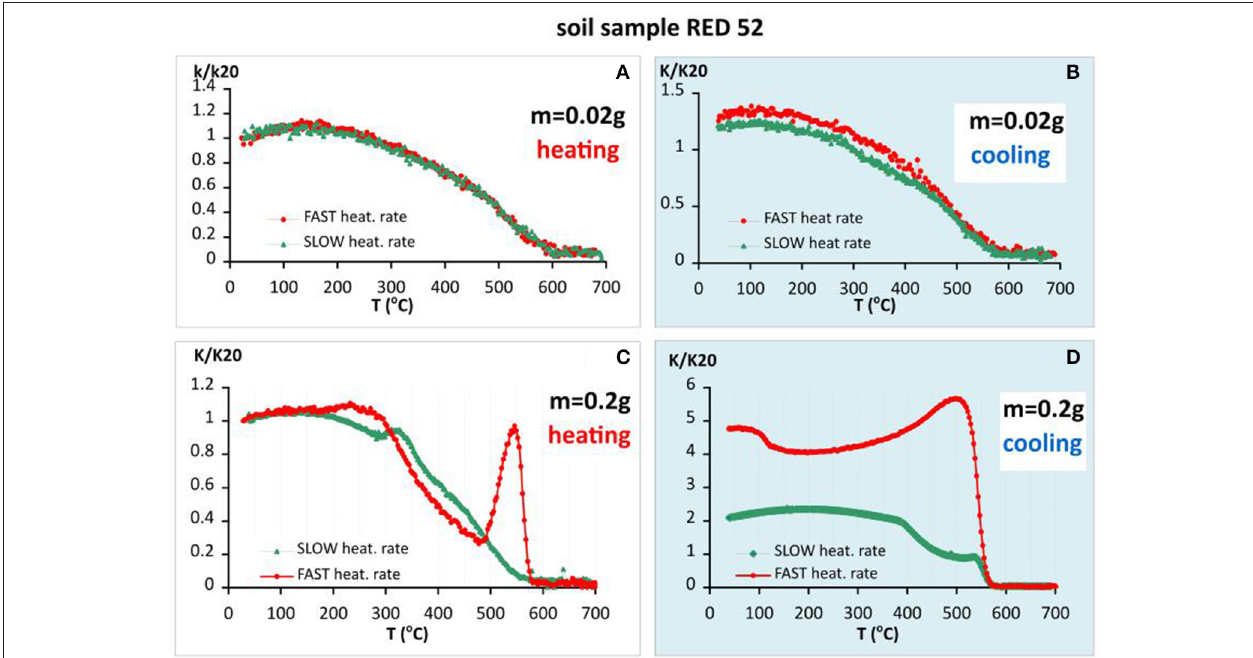
FIGURE 3 | Thermomagnetic analysis of magnetic susceptibility for soil sample RED 52 (Rhodic Luvisol), heating in air. (A) Heating curves using fast and slow heating rates for small sample size ( m = 0.02g); (B) cooling curves using fast and slow heating rates for small sample size; (C) heating curves using fast and slow heating rates for large sample size ( m = 0.2g); (D) cooling curves using fast and slow heating rates for large sample